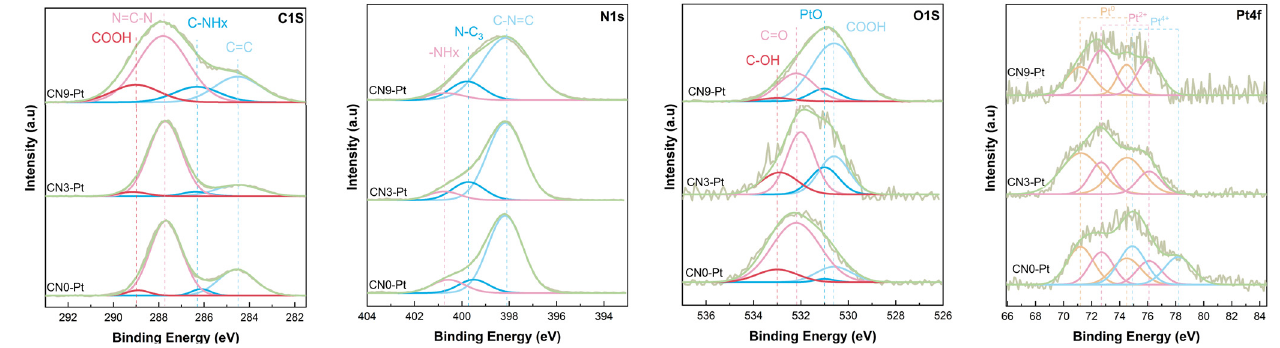
Figure 2. The XPS spectra of C 1s, N 1s, O 1s, and Pt 4f of CNx ‐ Pt photocatalysts. Table 1. Elemental analysis, Pt content (wt.%), and the atomic percentage of O-containing func- tional